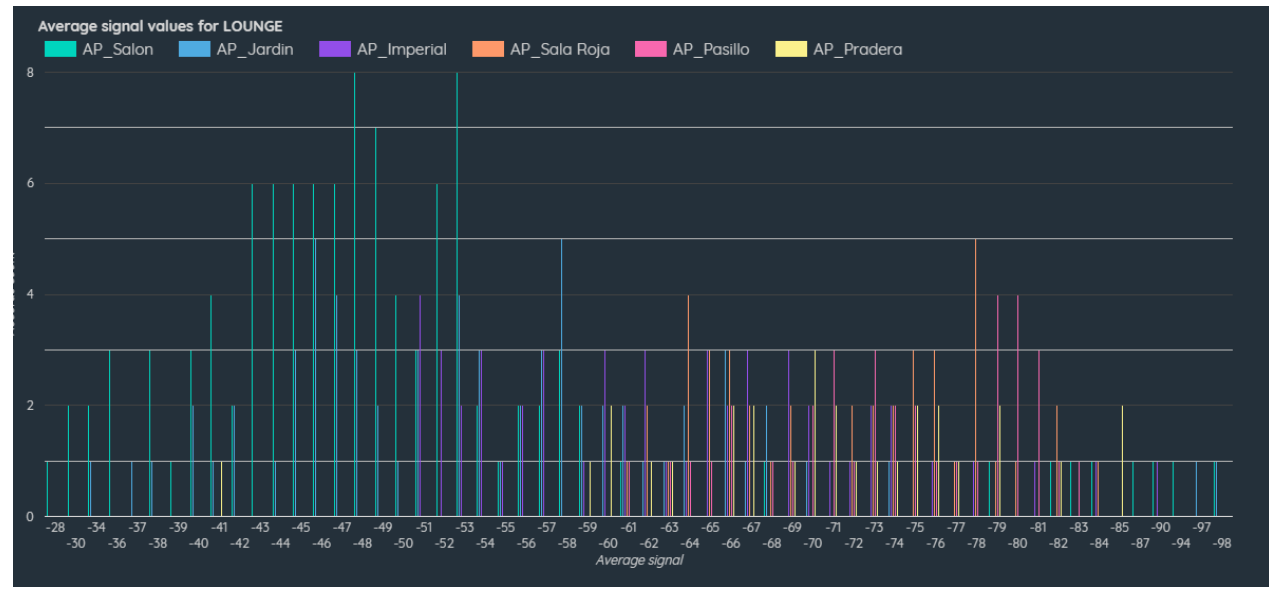
Figure 8. Data collection schedule for the 3 data collection methods: QMv. punctual data collection through walkthroughs; QMs, continuous data collection while employees are present; QD, continuous data collection 24 h.